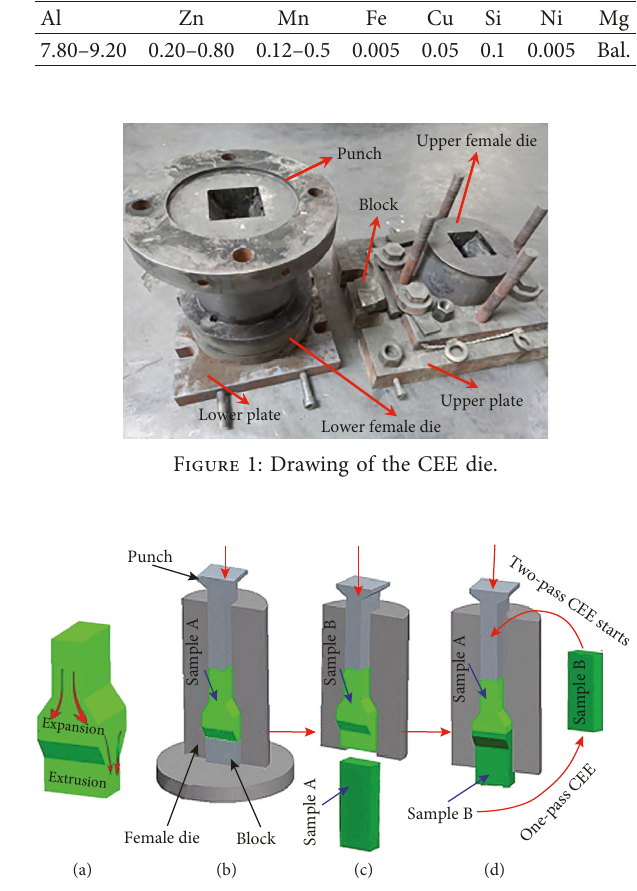
Figure 2: Schematic diagram of the CEE